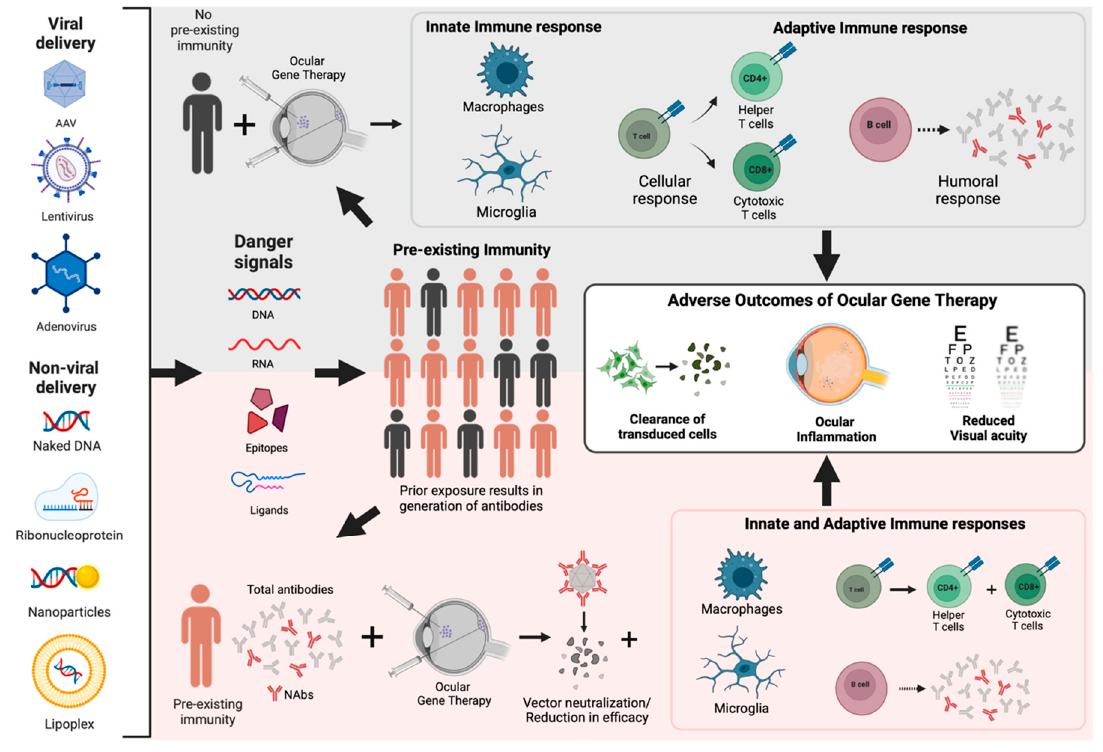
Figure 1. Schematic representation of immune responses to ocular gene therapy. Some components of viral and non-viral delivery methods present danger signals to the immune system. Exposure to these components prior to gene therapy can result in pre-existing immunity. Individuals without prior exposure can activate innate and adaptive mechanisms after receiving ocular gene therapy. Individuals with pre-existing immunity can generate neutralizing antibodies (NAbs) that eliminate the vector and further trigger innate and adaptive responses. To- gether, these responses can result in an adverse outcome of ocular gene therapy, such as clearance of transduced cells, inflammation and reduction in visual acuity.